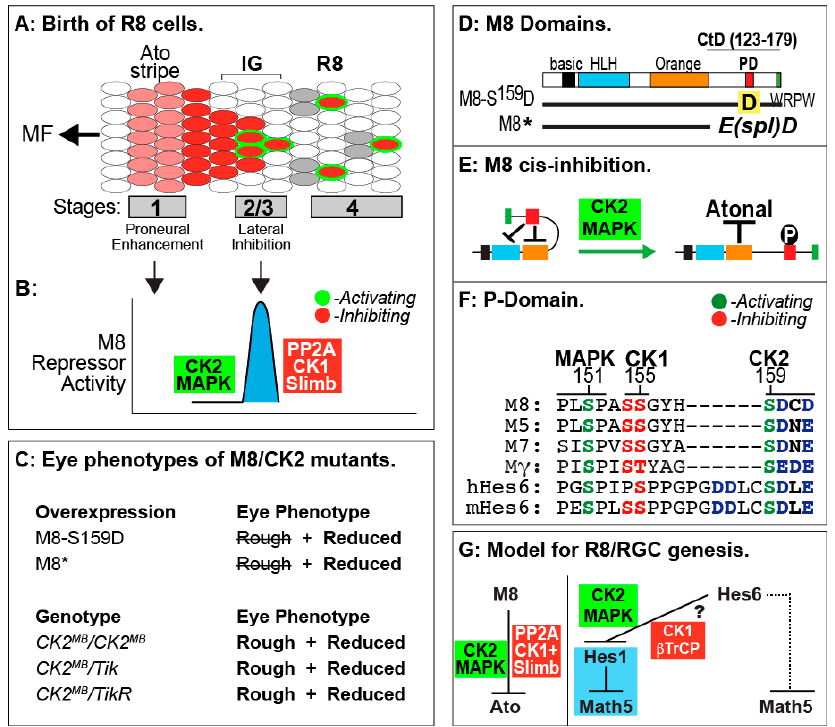
Figure 2. ( A ) R8 birth; Ato (pink/red), Sens (blue) and secondary R cells (grey); ( B ) CK2 and Mitogen Activated Protein Kinase (MAPK) activate M8 at stage-2/3 of the MF, and after R8 selection, PP2A and CK1 + Slimb mediate inactivation and/or destruction; ( C ) Eye phenotypes of CK2 and M8 mutants; ( D ) Functional domains in M8, and location of the phosphorylation domain (PD) in the C-terminal domain (CtD). The WRPW motif in M8 binds the essential co-repressor Groucho, and M8* (the product of the E(spl)D mutation) eliminates the CtD; ( E ) Regulation of cis-inhibited M8 by CK2 and MAPK. Note that in cis-inhibited M8, the PD blocks either HLH (blue) or Orange domains preventing interaction with Atonal; ( F ) Conservation of the PD in Drosophila M8/M5/M7/M γ and human/mouse Hes6; ( G ) Model for CK2 regulation of Drosophila M8 and mammalian Hes6. Dotted line denotes non-canonical mode of Hes6 action.